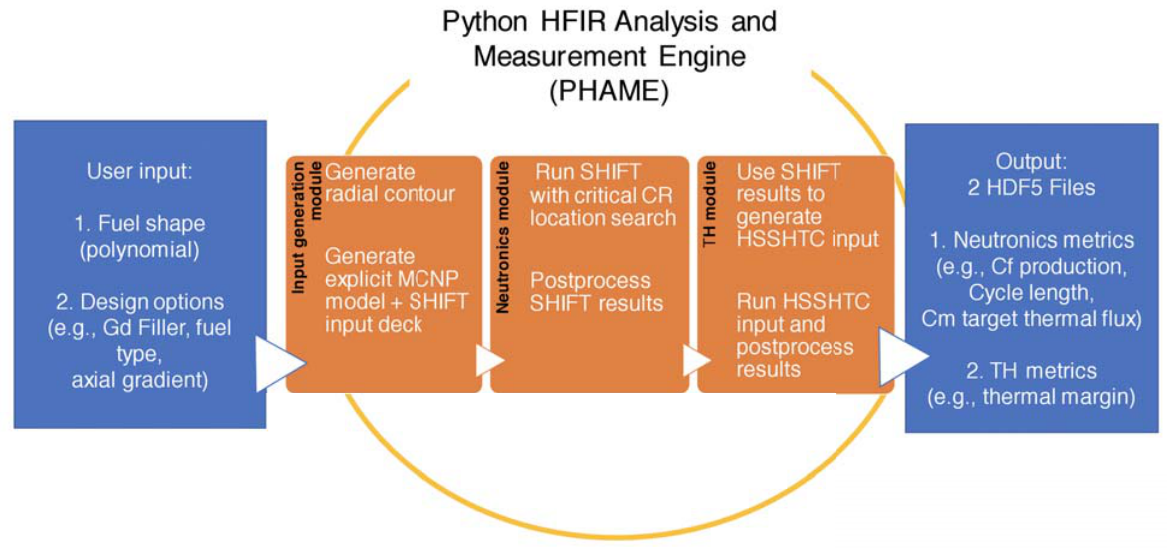
FIGURE 2. New Workflow of a More Automated HFIR Fuel Design Study.